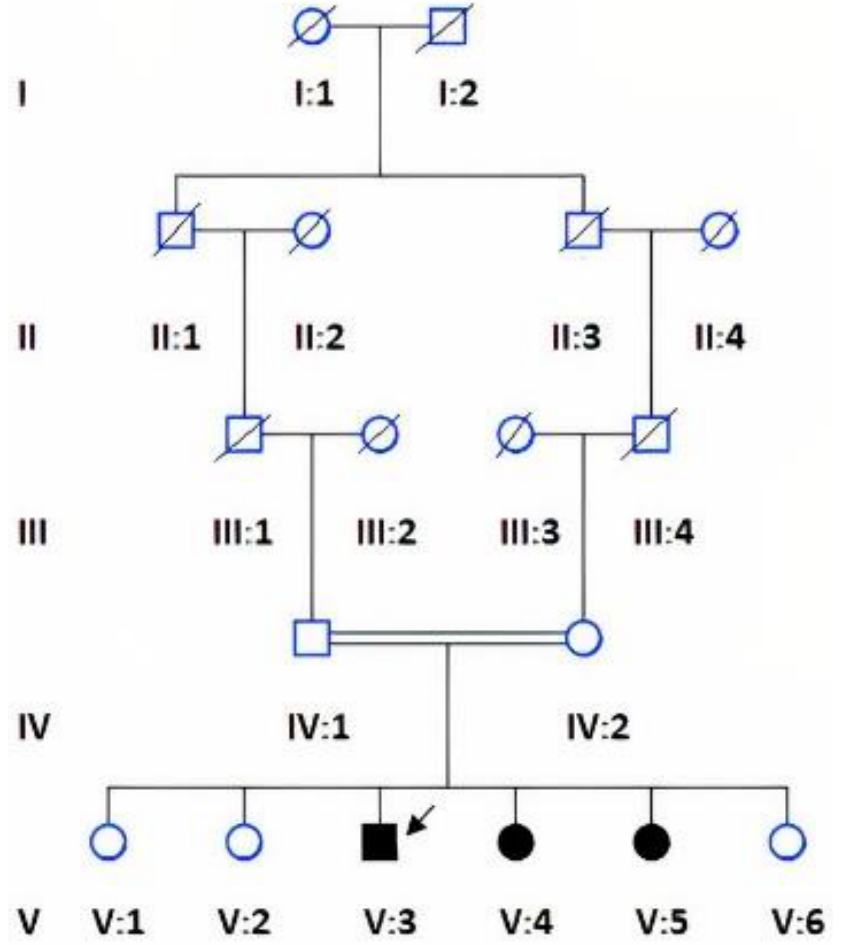
Figure 1. Pedigree of the family showing parental consanguinity, circles indicate female gender and squares males, filled square and circles indicate affected individuals, arrow points to the proband.